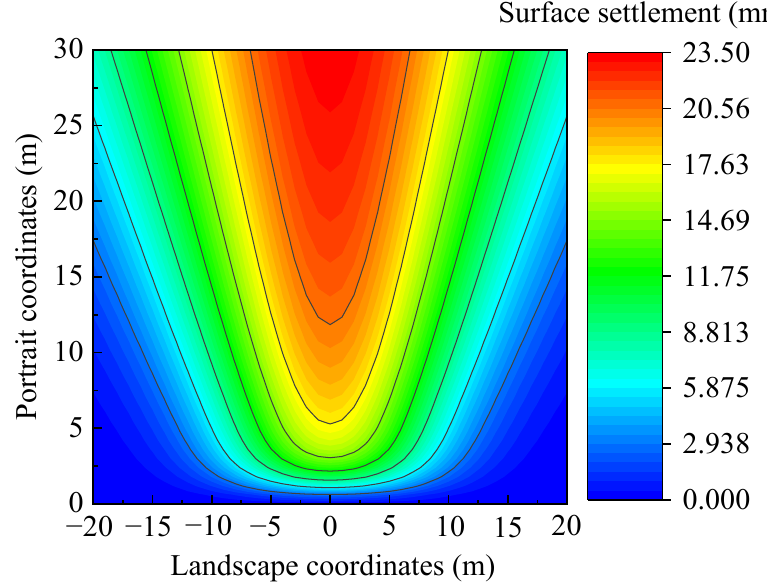
Figure 6. Cloud map of surface settlement distribution.